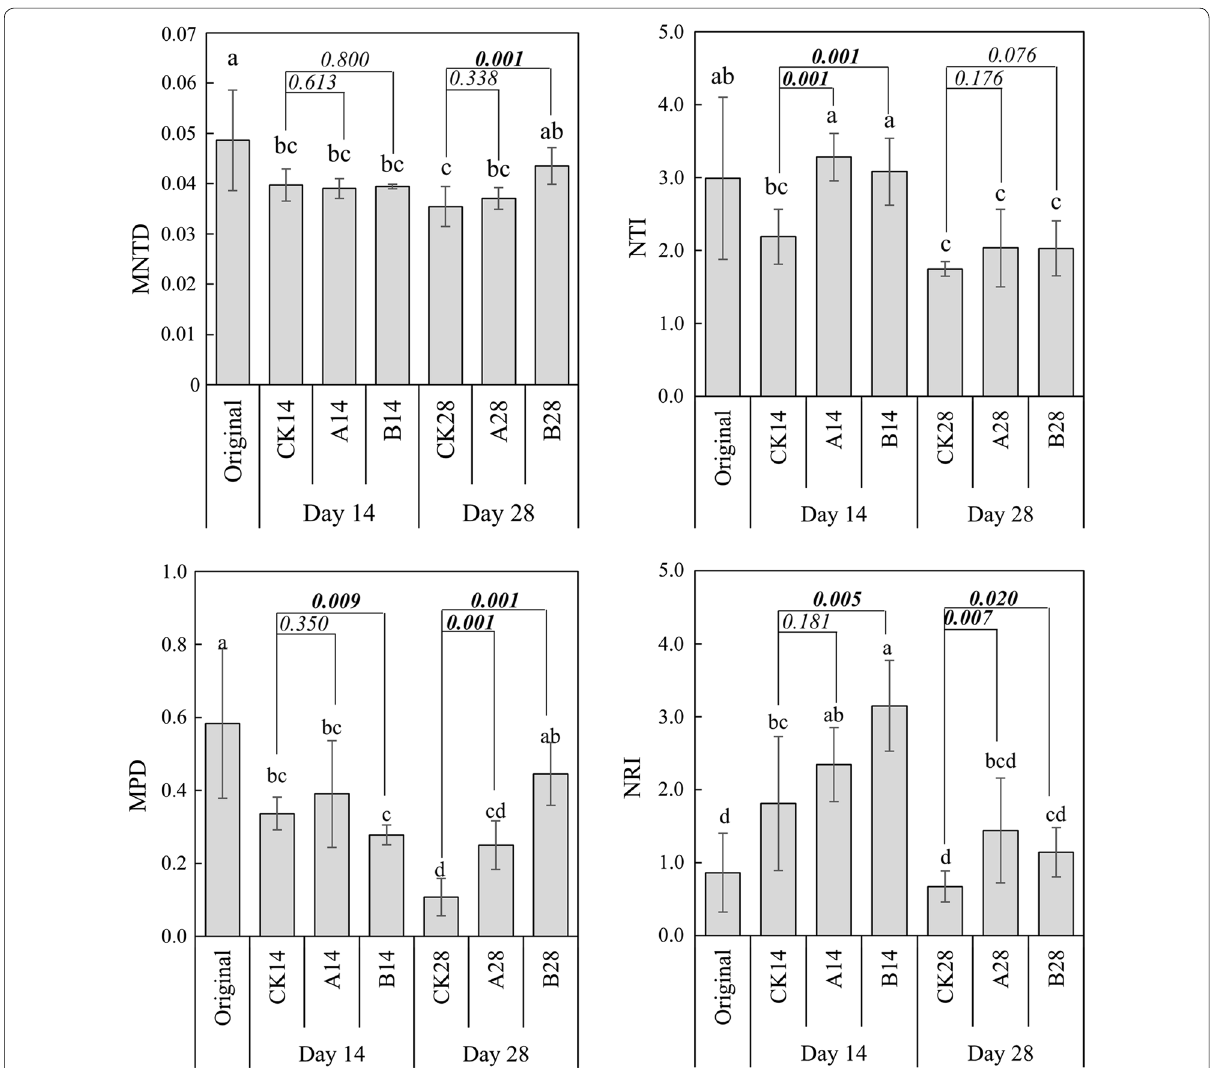
Fig. 3 Phylogenetic diversity of phyllosphere microbial communities. MNTD mean nearest taxon distance, NTI near taxon index, MPD mean phylogenetic distance, NRI net relatedness index. Results are expressed as means and SD (error bar) of 8 replicates, statistically significant differences ( p < 0.05) in values between treatments are indicated through different letters above the columns, numbers between two columns are p values of student t